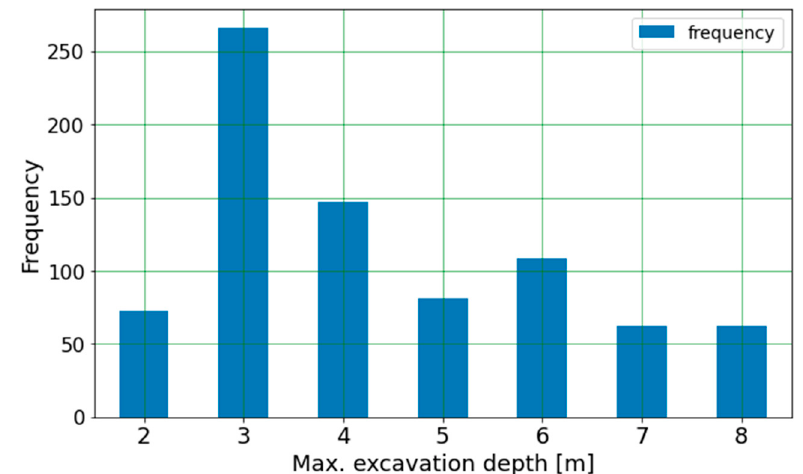
Figure 4. Distribution of maximum excavation depth for the FE models.